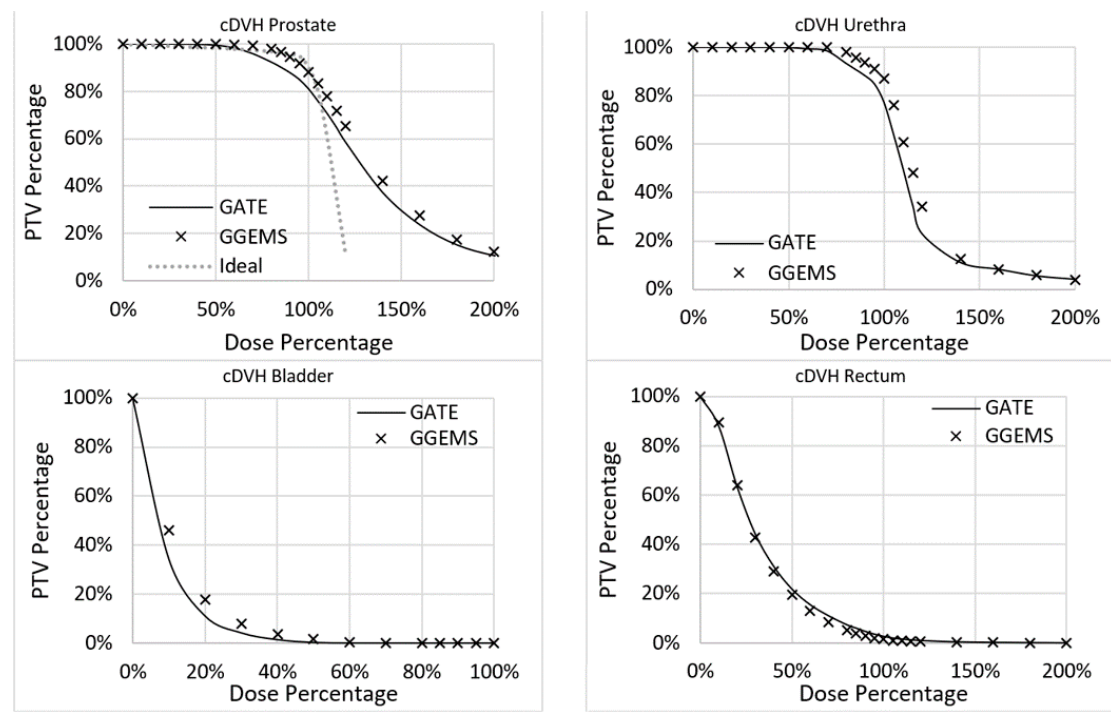
Figure 9. cDVH for the four segmented